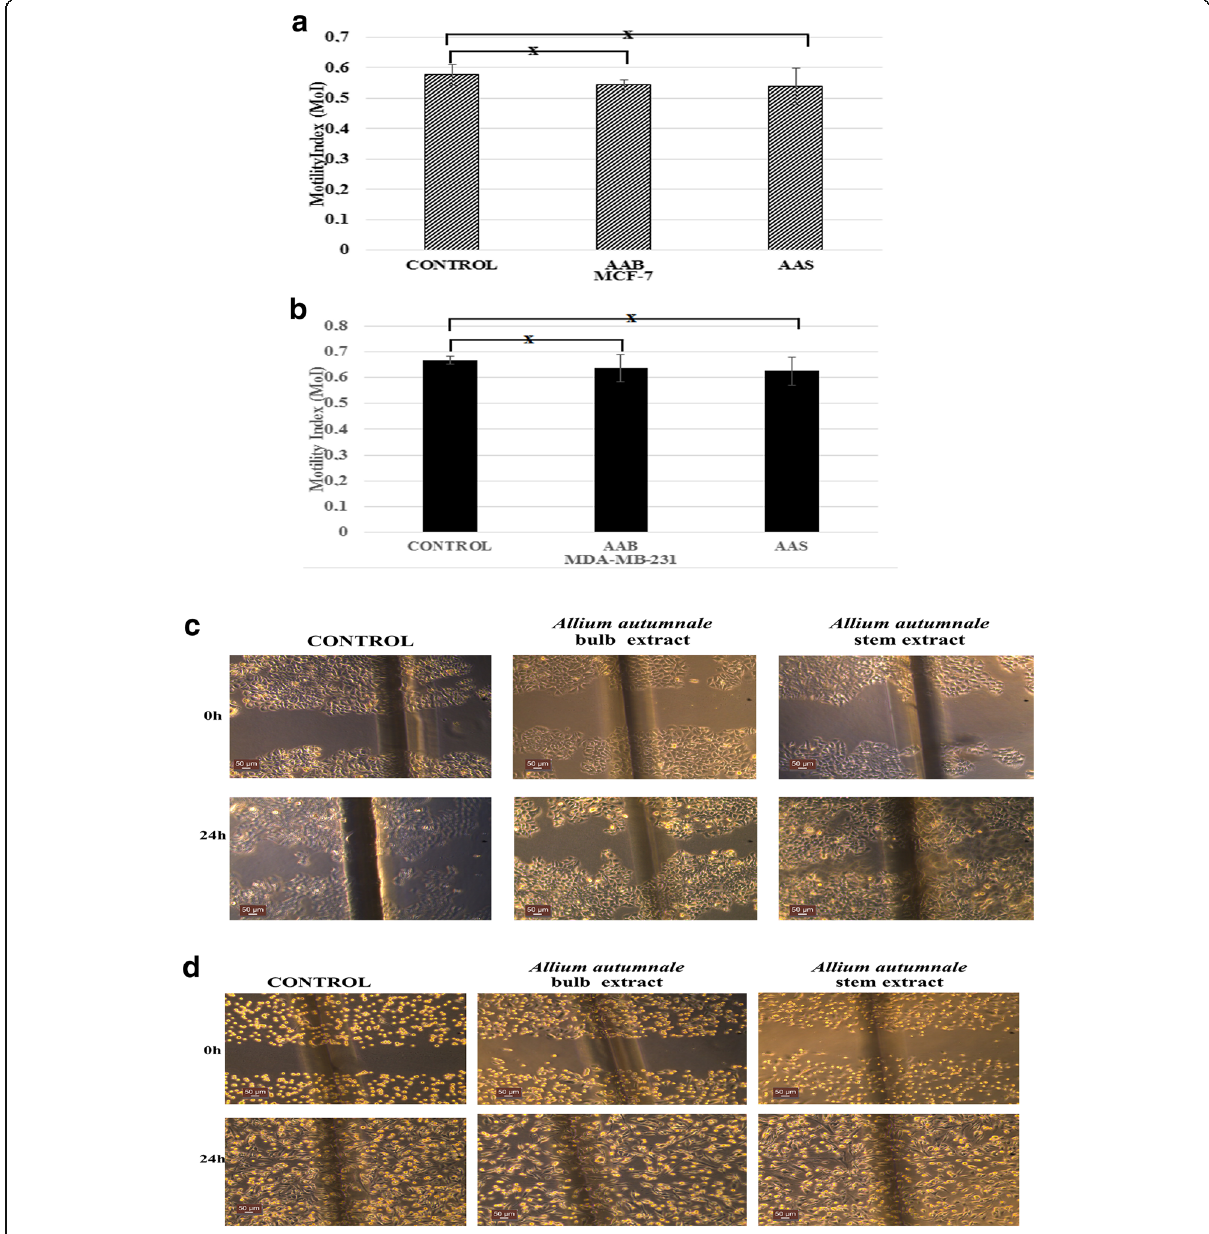
Fig. 6 Effects of AAB and AAS on lateral motility of MCF-7 and MDA-MB-231 cells from 24 h incubation. Bar graph showing lateral motility data obtained for MCF-7 ( a ) and MDA-MB-231 ( b ) for 24 h incubation. “ x ” represents no significant difference compared to the control experiments. Representative inverse light microscope images of AAB and AAS incubation of MCF-7 ( c ) cells and MDA-MB-231 ( d ) which caused no significant effect on lateral motility. Scale bars = 50 μ